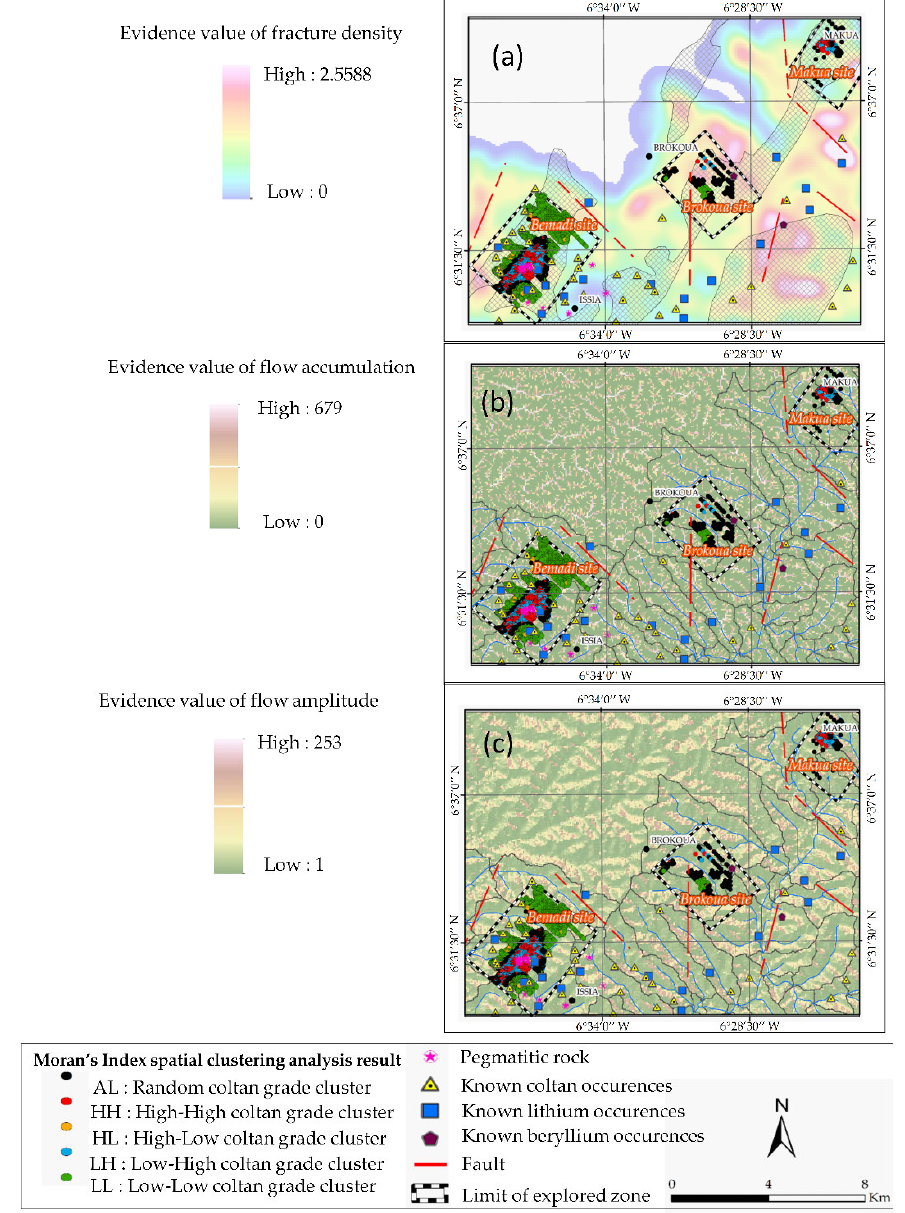
Figure 5. ( a ): Evidence maps of structural parameters (fracture density). ( b ): Evidence map of hydrological parameters (flow accumulation). ( c ): Evidence map of hydrological parameters (flow amplitude). The values of the density parameter increase in the green to red color range (0 to 2.6). Yellow to yellow-orange areas represent areas of medium fracturing. The heavily fractured areas are magenta to red and the less fractured areas are green, dark blue and turquoise blue (Figure 5a). In step S2, fracture density parameter values of the landscape were extracted at the geographic coordinates of each pixel of the study area. The extracted values corresponding to each pit location were used as the structural predictor variable with machine-learning